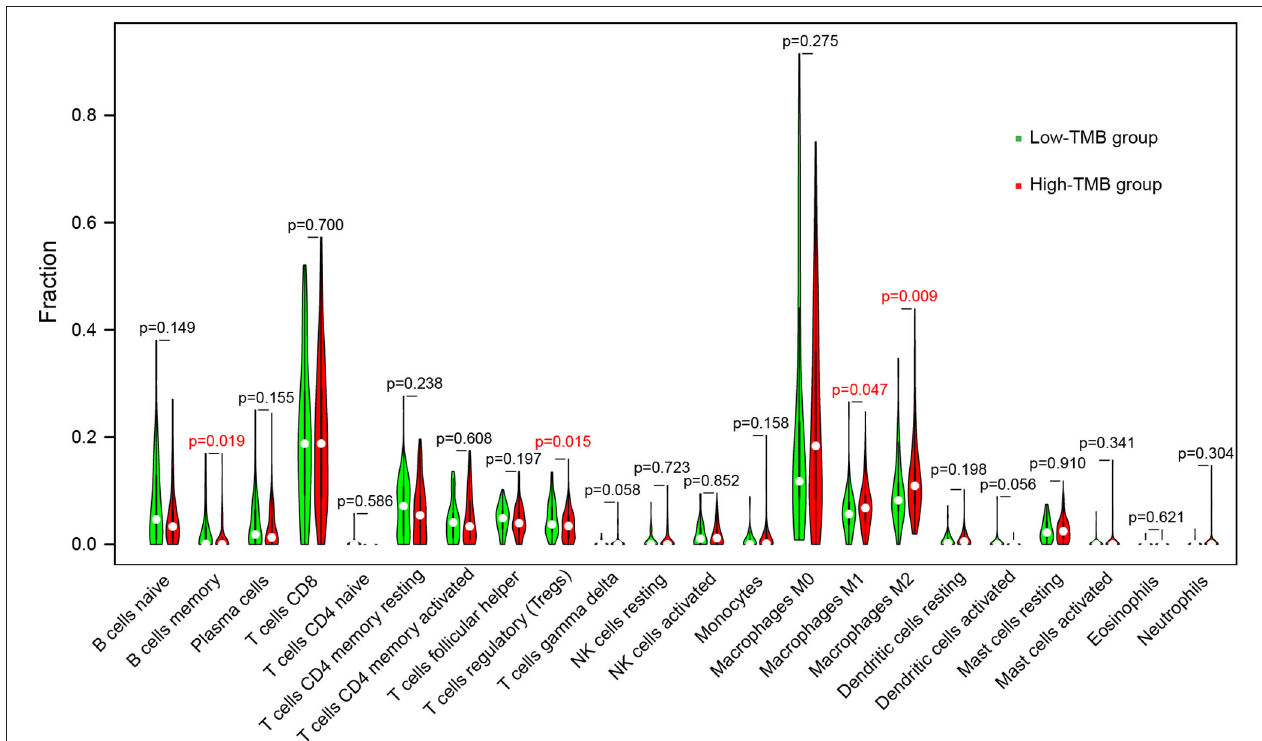
FIGURE 8 | Comparisons of abundance of infiltrating immune cells between low-TMB and high-TMB